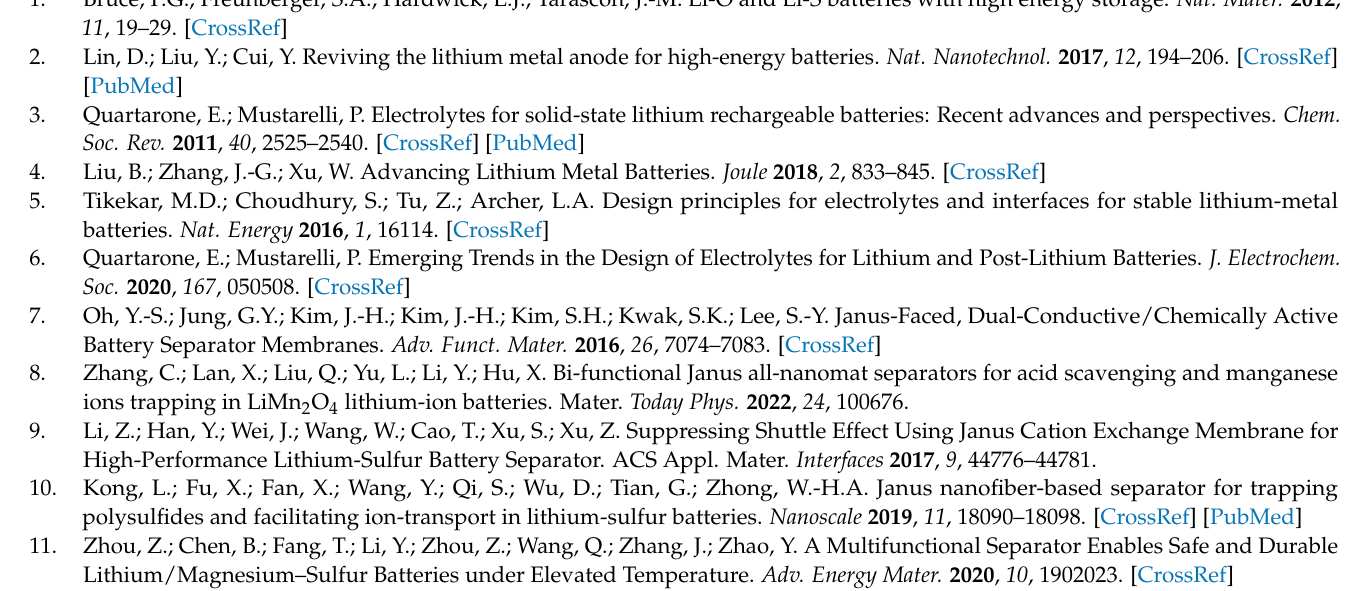
Figure S3. Backscattered electron images and SEM-EDX distributions on the isolating side of FULL 40 JM before cycling. Figure S4. Backscattered electron images and SEM-EDX distributions on the isolating side of FULL 40 JM after